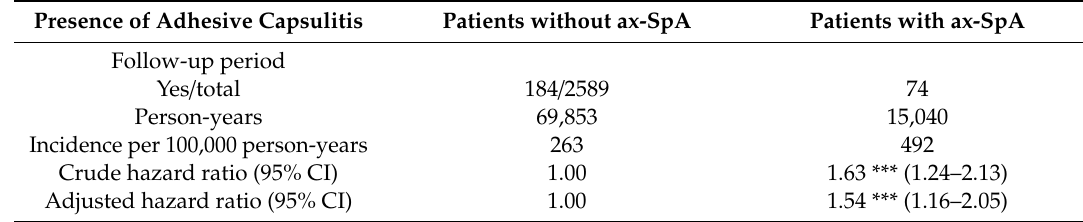
Table 2. Incidence and hazard ratio for adhesive capsulitis between patients with and without axial spondyloarthritis during the 7-year follow-up ( n = 14,295). Presence of Adhesive Capsulitis Patients without ax-SpA Patients with ax-SpA Follow-up period Yes / total 184 / 2589 69,853